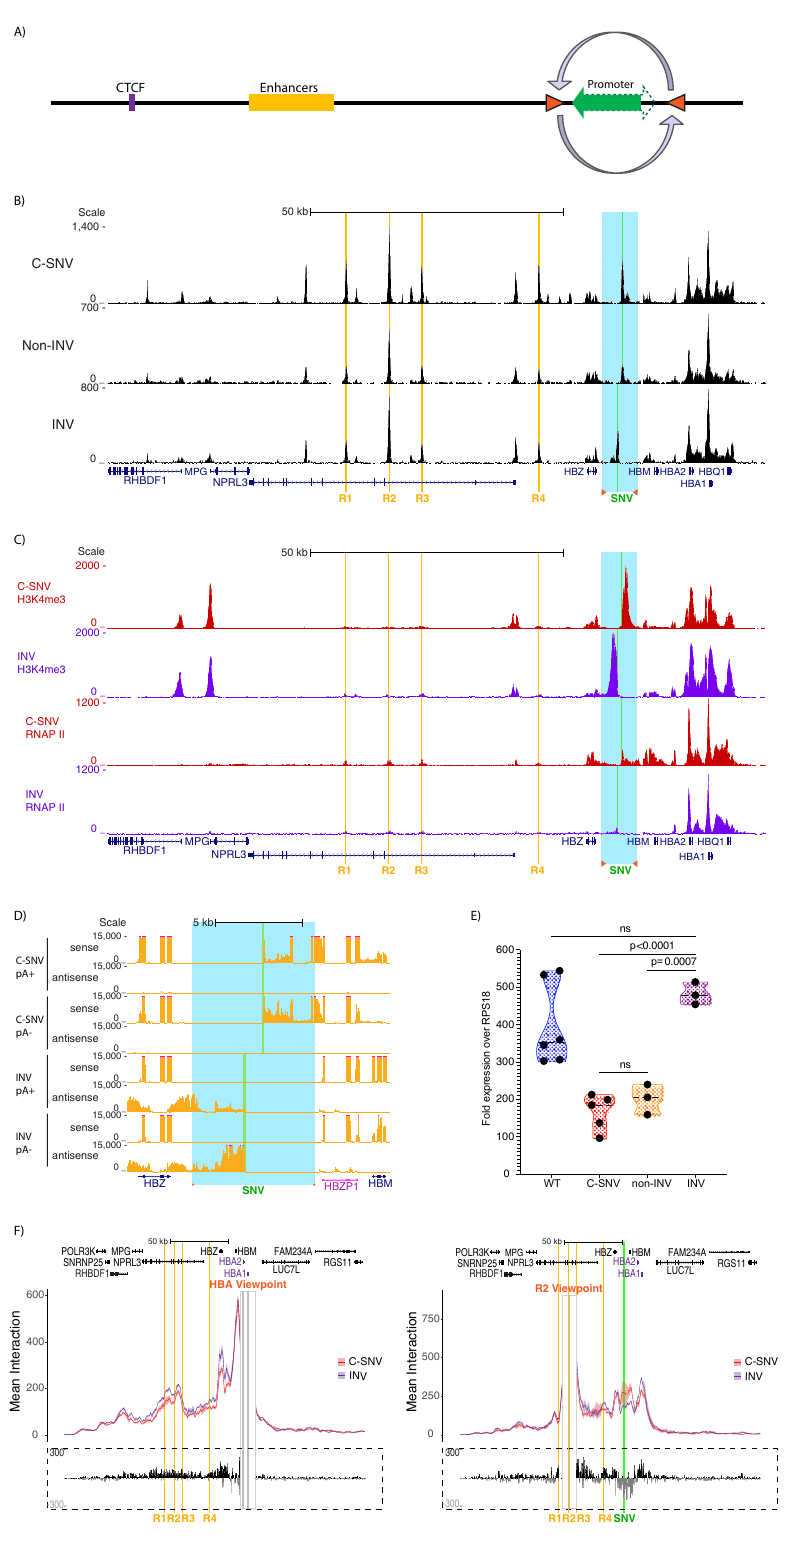
Wild type human induced pluripotent stem cell lines SB-AD2-01, SB-AD3-01 and AH017-13 were obtained from Oxford StemBANCC. C-SNV human induced pluripotent stem cell lines LA01, LA06 and LA13 were generated and validated in house. Ethical approval for the study was granted by North West Research Ethics Committee of NHS National Research Ethics Services, Ref: MREC 03/8/097. The experimental procedures in this study were carried out in accordance with the approved guidelines. Informed consent was obtained for the generation of human derived iPSC